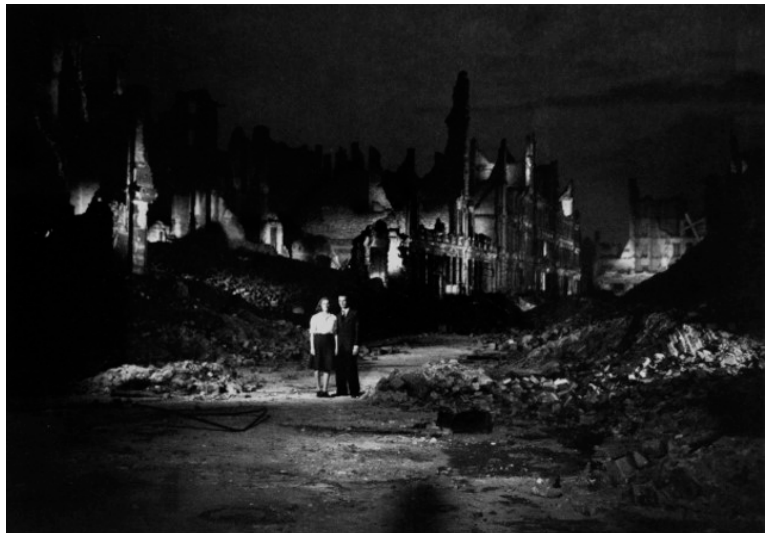
Figure 2. Henry Ries. Angestrahlte Ruinen für die Dreharbeiten zum dem DEFA-Film “Die Mörder sind unter us” mit Hildegard Knef und Wilhelm Borchert ( Illuminated Ruins for the Shooting of the DEFA Film “The Murderers Are Among Us” with Hildegard Knef and Wilhelm ). OMGUS Observer , 19 July 1946, p. 7. Photograph. © Henry Ries. Deutsches Historisches Museum. Invoice No. 2007 / 4176.102, file PH009419.